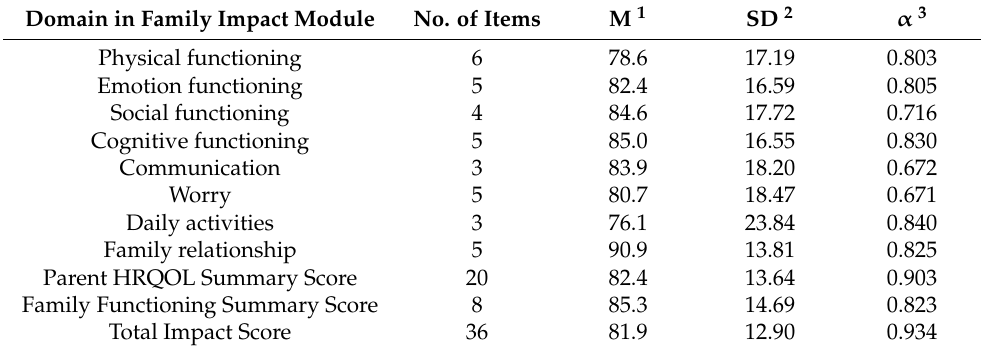
Table 3. Mean Score and Cronbach’s Alpha of PedsQL Family Impact Module Among Participants ( n = 159).